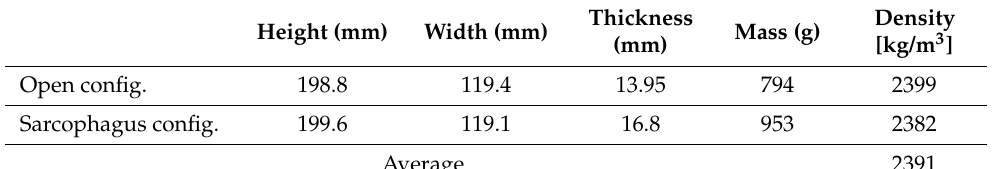
Thickness Density Mass (g) (mm) [kg/m 3 ]